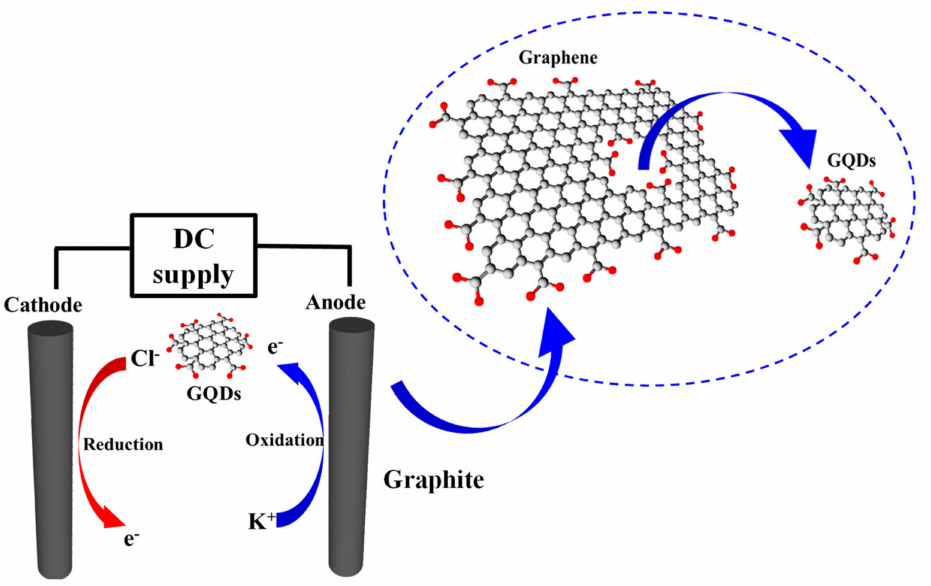
Figure 5. Schematic diagram of GQDs growth mechanism in the electrochemical exfoliation process via graphite rods